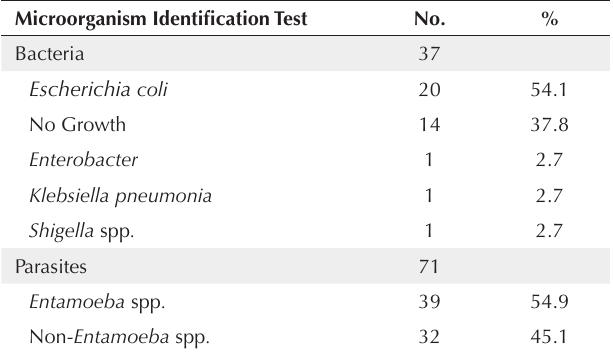
Table 3. Identified Microorganisms Microorganism Identification